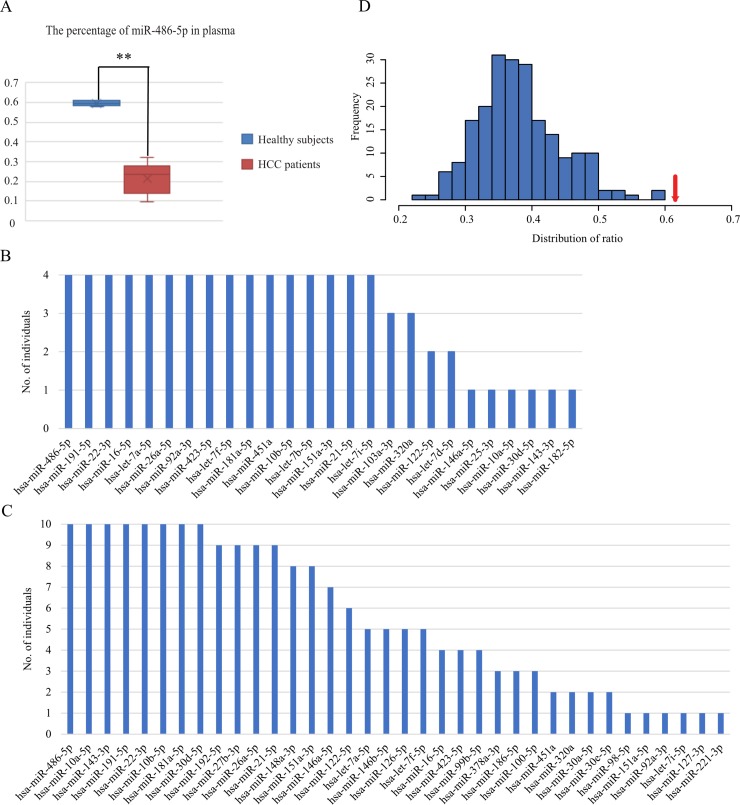
Most abundant miRNAs in plasma.A. miR-486-5p is more abundant in the plasma of healthy subjects. B. The collected dataset of the top twenty most abundant plasma miRNAs in healthy subjects. C. Collected dataset of the top twenty most abundant plasma miRNAs in HCC patients. D. Distribution of the ratio of the miRNAs shared by all the individuals. Four individuals among ten HCC patients were randomly sampled for two hundred and ten times. The red arrow indicates the ratio of the healthy subjects.